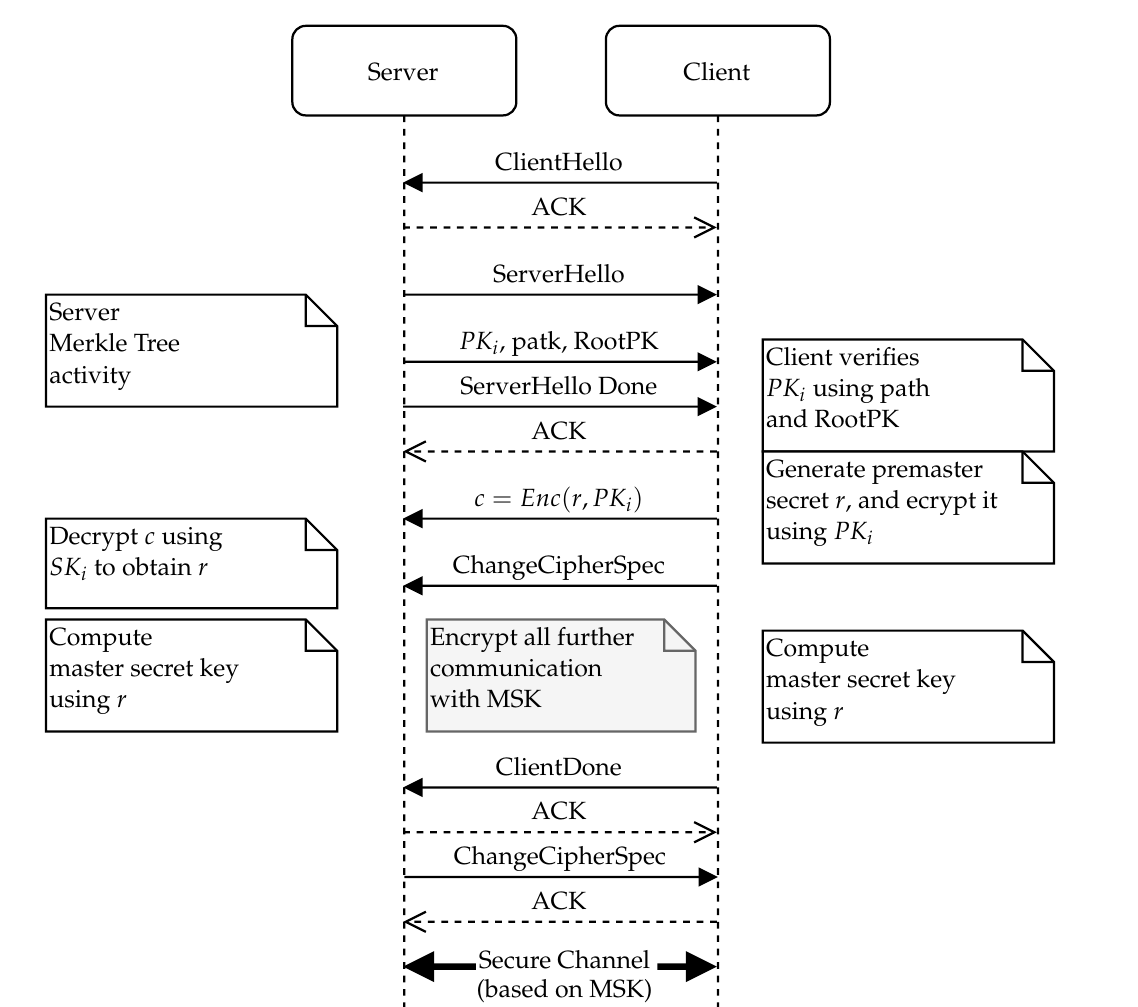
Figure 5. Overview of the protocol use within TLS 1.2 scope for client-server communication [27]. PK, public key.